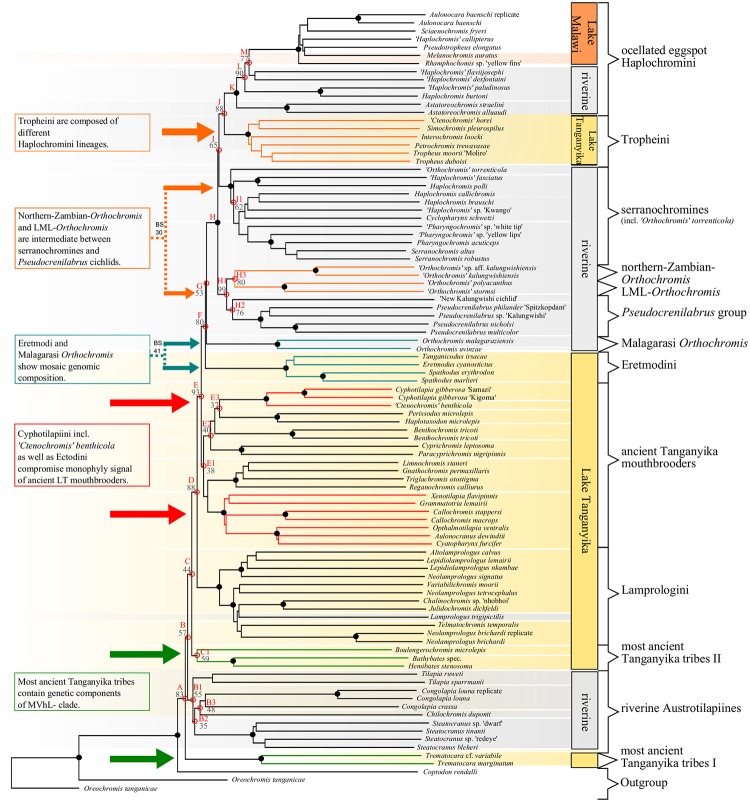
NJ-consensus phylogeny of AFLP data and major effects revealed with HET.The NJ consensus topology is based on Jaccard’s distances [62] of 3312 nc loci. Nodes affected by homoplasious effects are designated with letters A-M and indicated by open, red circles. Numbers at nodes refer to bootstrap-values (BS 500 replicates) and a 100% BS support is indicated by filled, black circles. Geographic distribution of taxa is depicted vertically on the right and colour shaded in the tree (Lake Tanganyika: yellow; Lake Malawi orange; rivers: grey). Major effects detected with HET and inference of cyto-nuclear discordances are delineated in coloured boxes on the left and correspond to those in Fig 6 and Fig 8. Arrows and coloured branches point to clades which especially introduce homoplasy in the dataset. Strong alternative signal (BS support >30) is denoted with dotted lines on the left.